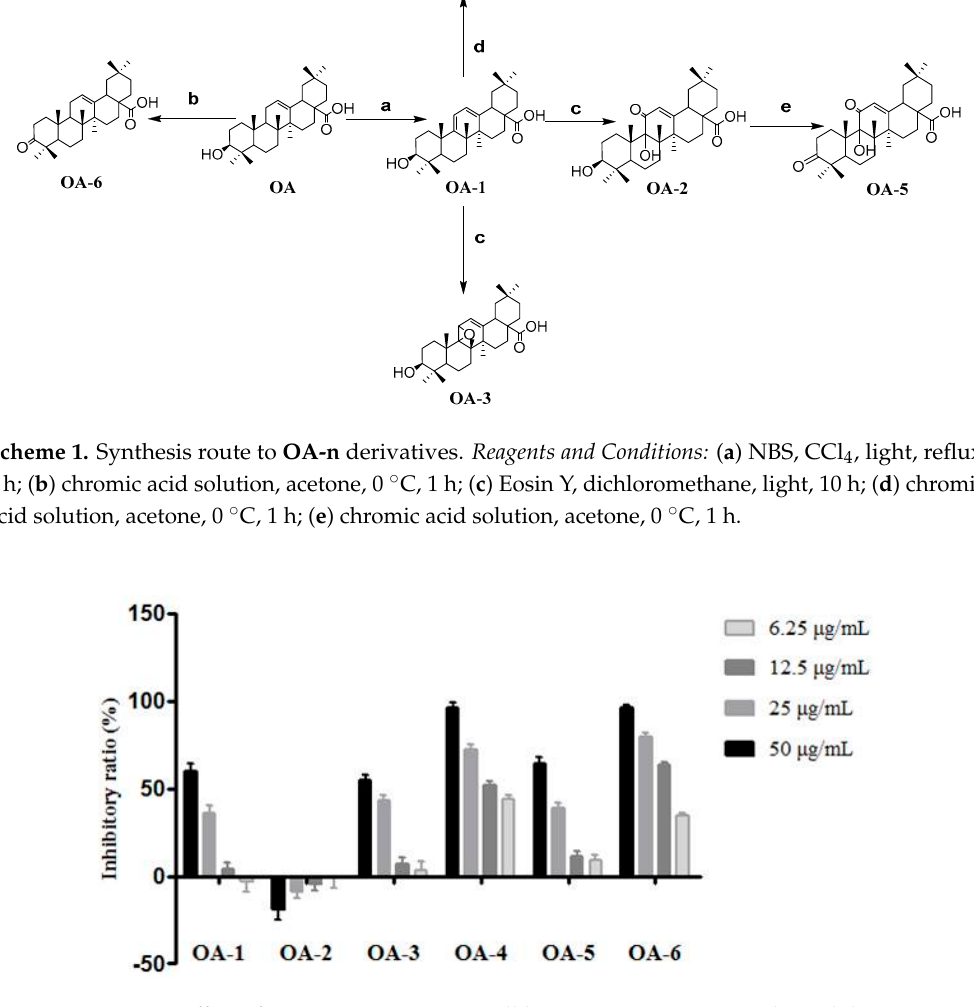
Figure 2. Cytotoxic effect of OA-n on HepG2.2.15 cell line. Data were expressed as inhibitory ratio ± SD based on three independent experiments. Table 1. TC 50 and TC 0 values (µg/mL) of OA-n on HepG2.2.15 cell line.